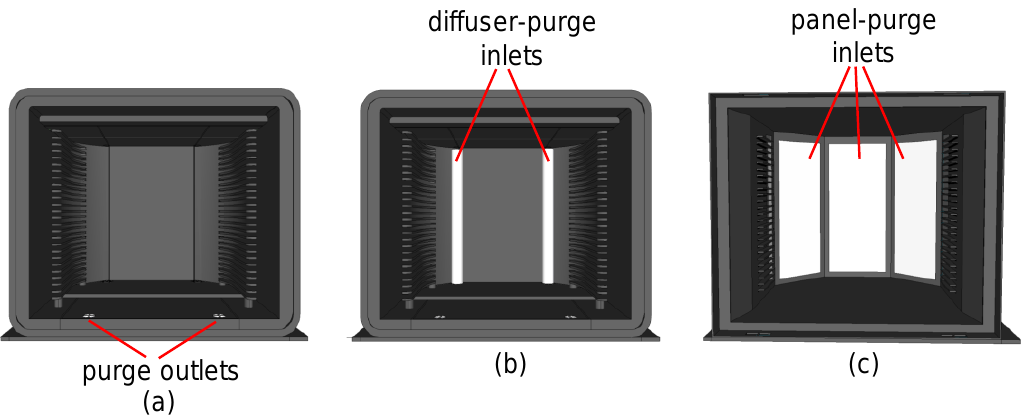
Figure 3. Different types of FOUPs employed for ( a ) conventional-purge, ( b ) diffuser-purge, and ( c ) panel-purge processes.